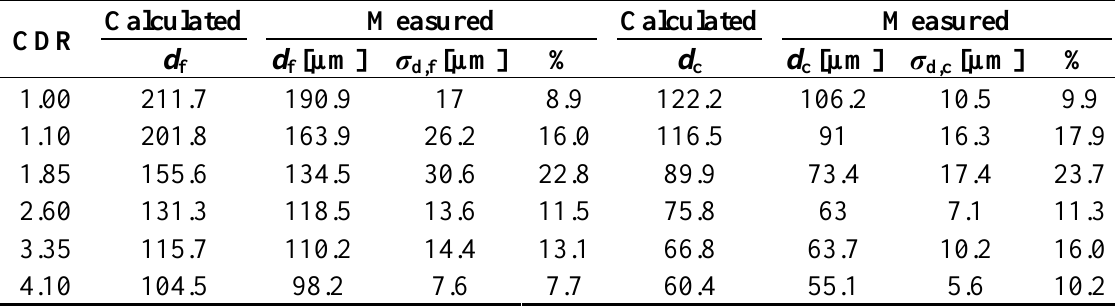
Table 5. Calculated and measured values for sheath and core diameters as well as statistically determined standard deviations.